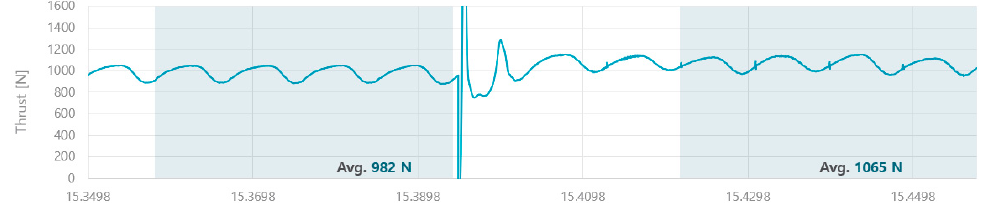
Figure 17. Thrust of composite propeller (model 1) before and after the co-simulation in the cavitating flow.